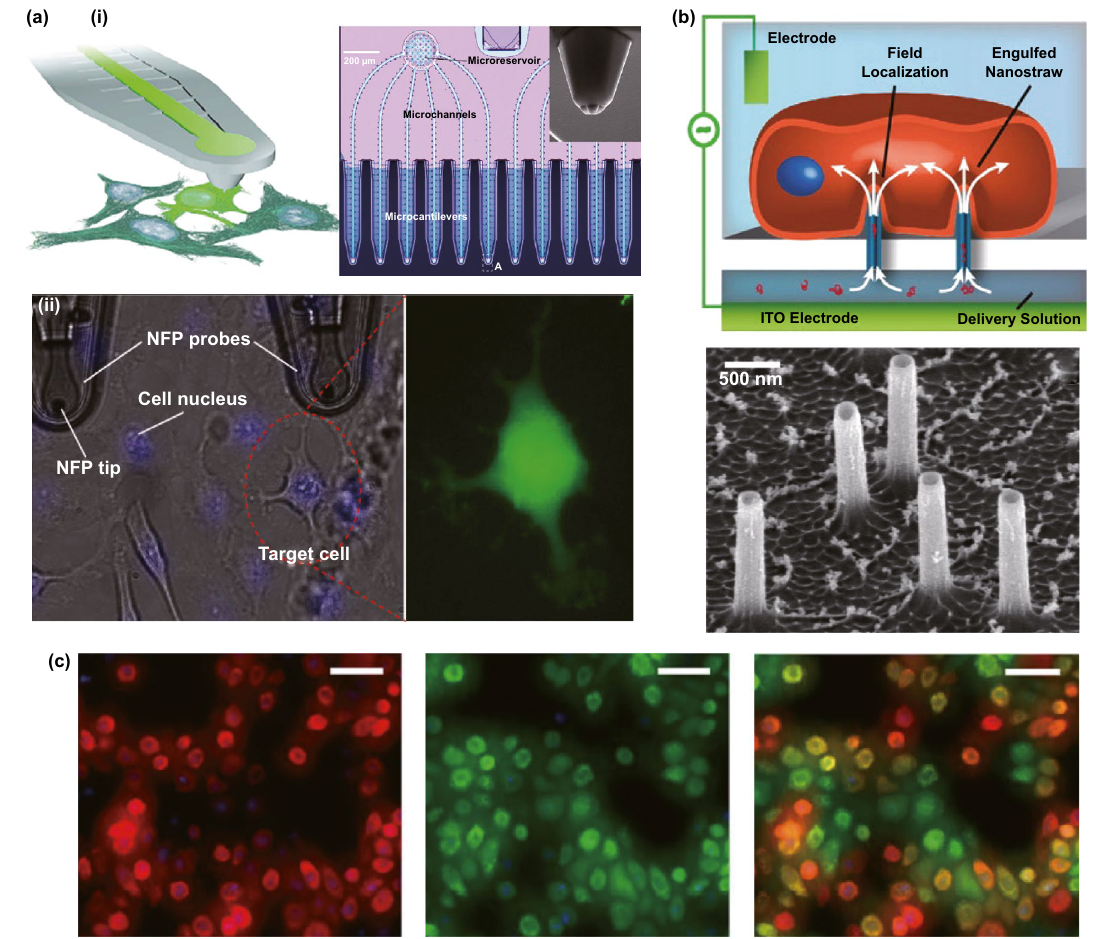
Fig. 5 a (i) Optical image of NFP chip used for single‑cell electroporation and SEM image of the tip of NEP. (ii) Optical images of transfec‑ tion of dextran Alexa Fluor 488 into target HeLa cells with NFP tip and fluorescence images of the transfected HeLa cells [115]. b , c The tight contact between the nanostraw‑plasma membrane interface allowed high‑efficient transfection of pRFP [83]. Reproduced with permission from Refs. [83, 115], copyright (2013) American Chemical Society Publishing Group and (2013) American Chemical Society Publishing